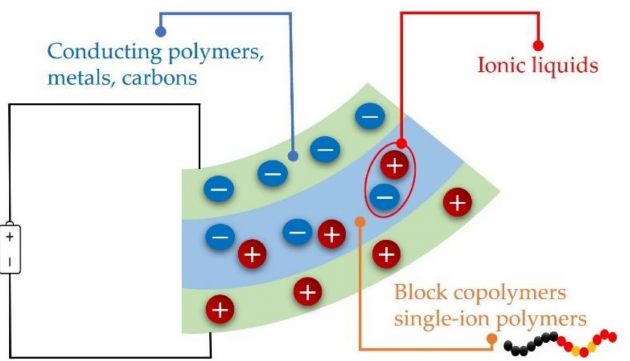
Figure 2. Composition of an ionic EAP actuator with an ionic liquid in the center and electrodes on either side (Redrawn with permission from [18]. Copyright Royal Society of Chemistry,